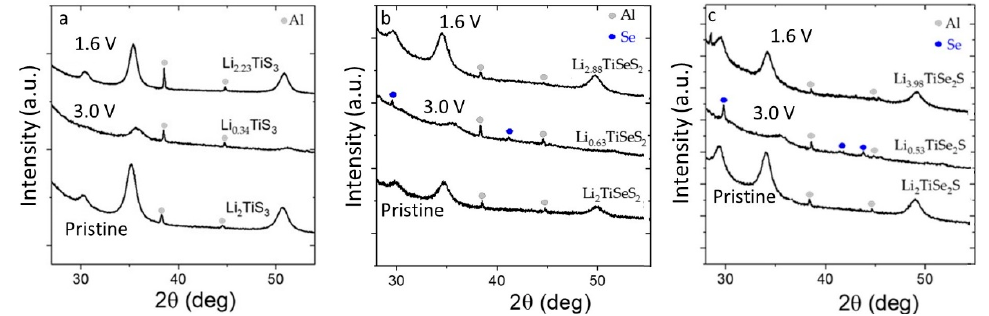
Figure 7. Ex situ X-ray diffractograms of ( a ) Li 2 TiS 3 , ( b ) Li 2 TiSeS 2 , and ( c ) Li 2 TiSe 2 S electrodes at different states of charge: pristine, at the end of charge (3 V), and at the end of discharge (1.6 V).